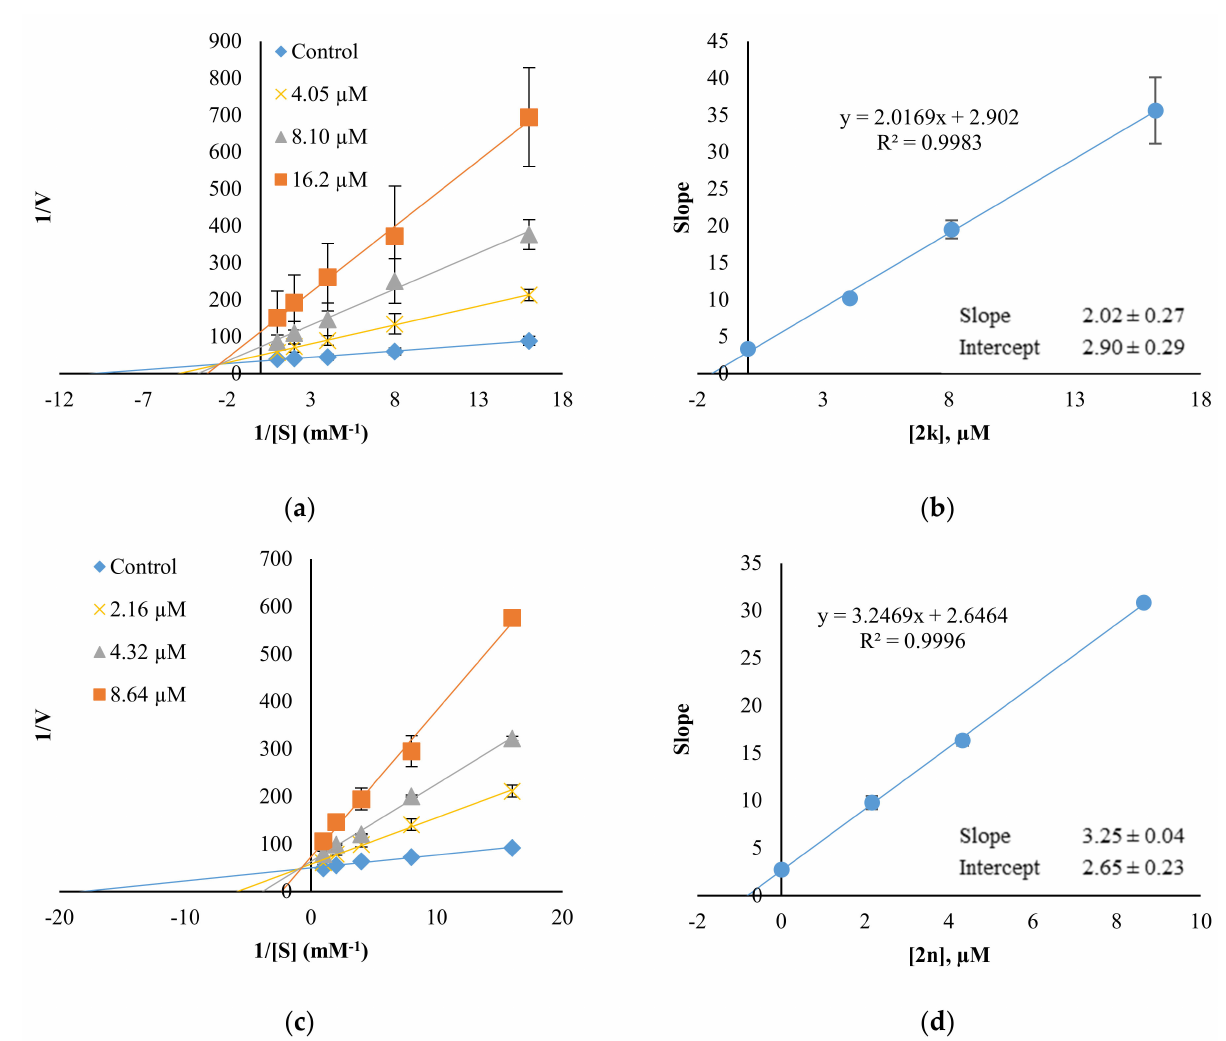
Figure 5. Lineweaver–Burk plots ( a , c ) and their secondary plots ( b , d ) of 2k and 2n for AChE. Five concentrations of ATCI were used; 0.0625, 0.125, 0.25, 0.5 and 1.0 mM, respectively, and three concentrations of inhibitor were ~1/2 × , 1 × , and 2 × IC 50 : 4.05, 8.10, and 16.20 µ M for 2k ; 2.16, 4.32, and 8.64 µ M for 2n . The K m value for AChE was 0.075